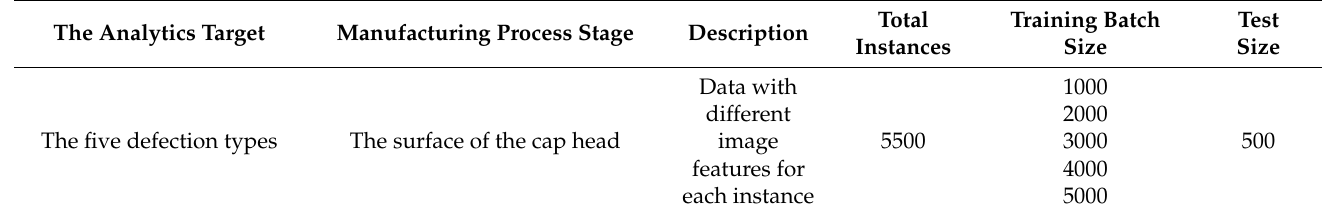
Table 4. List of datasets.